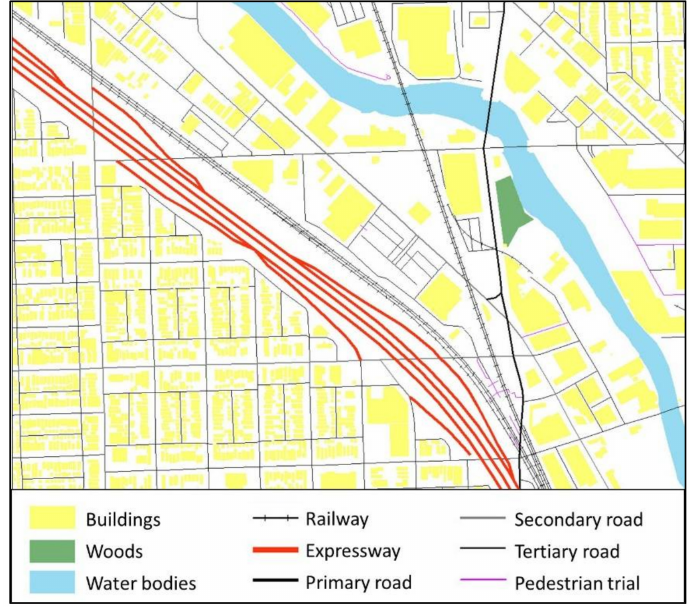
Figure 2. Accessibility-related environmental contexts.